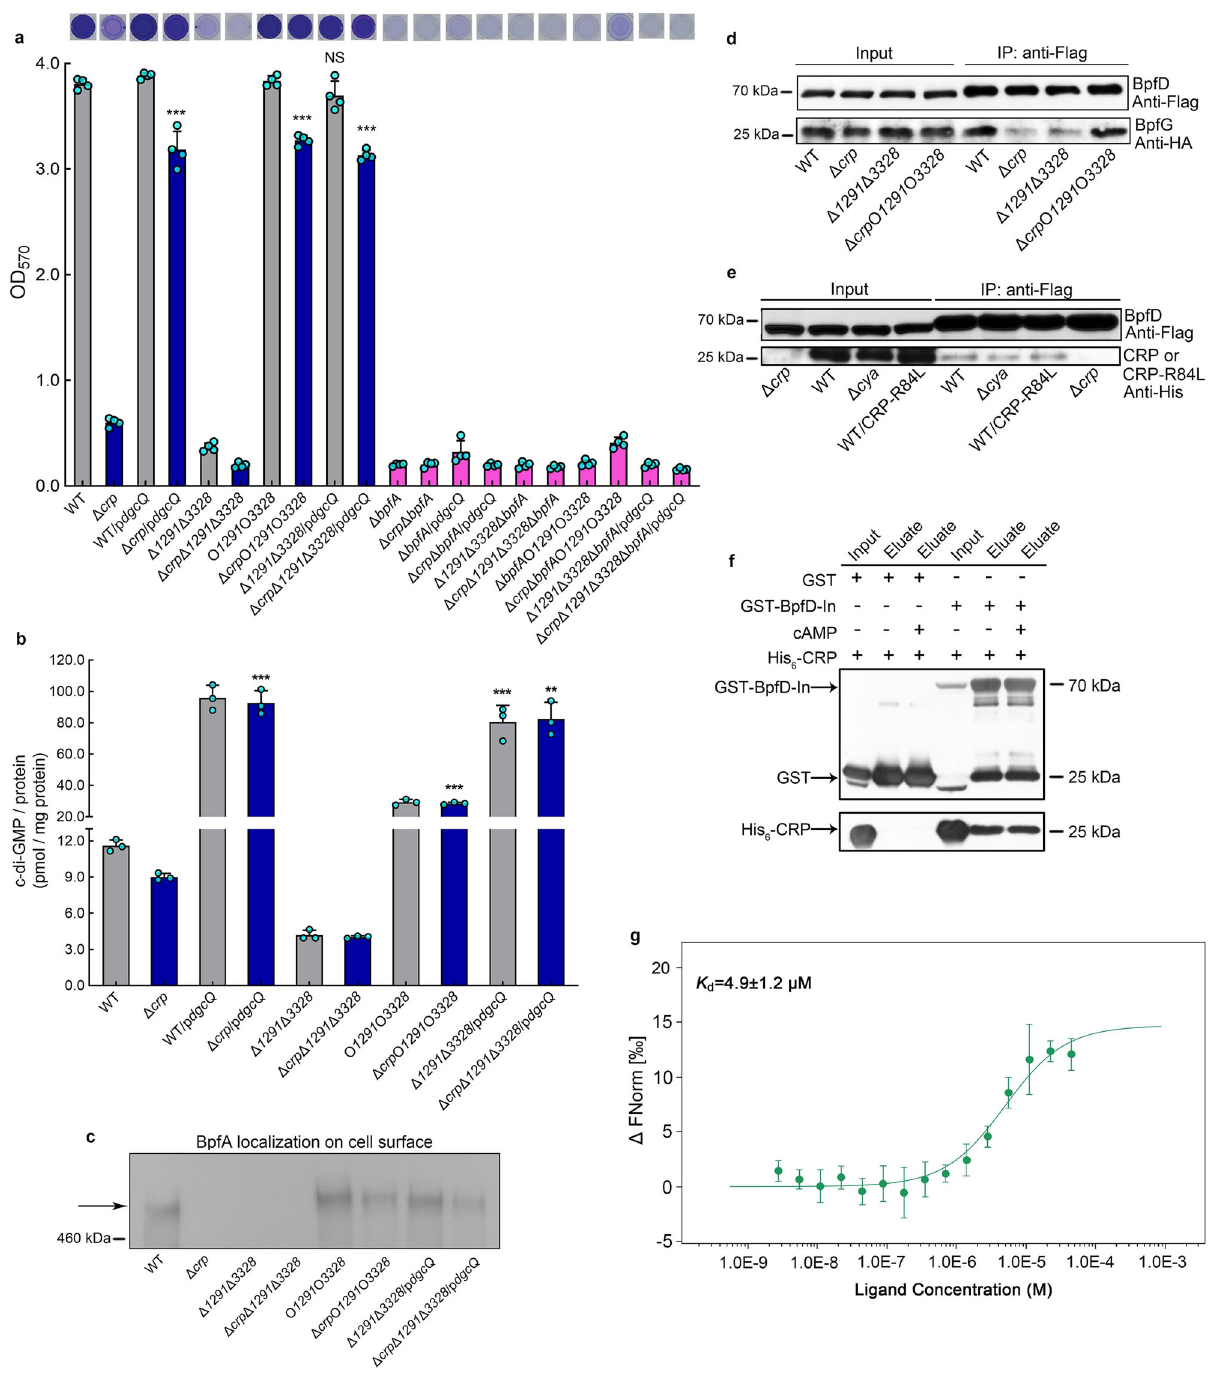
Fig. 5 Direct interaction between cAMP-CRP and BpfD retains BpfA localization on the cell surface. a Bio fi lm biomass ( n = 3 independent samples). b Intracellular c-di-GMP concentration ( n = 3 independent samples). c Western blotting detection of BpfA localization on the cell surface. d Co-IP to analyze the interaction between BpfD and BpfG in vivo. e Co-IP to analyze the interaction between BpfD and CRP/CRP-R84L in vivo. All strains used in ( a – e ) were cultured for 30 h in the bio fi lm state. f GST pull-down assay showing the interaction between BpfD intracellular domains and CRP in vitro. g MST showing the interaction between BpfD intracellular domains and CRP in vitro, data are shown as the mean ± SD ( n = 3 independent samples). The native promoter region of the bpfA operon of the strains used in ( c – e ) was replaced by the constitutive promoter P aacC1 . Insets in ( a ) are the bio fi lm pictures of crystal violet dyeing. Data in ( a , b ) are shown as the mean ± SD. Two-sided Student ’ s t test was used in ( a , b ) to analyze the statistical signi fi cance (NS: No signi fi cance. ** p < 0.01. *** p < 0.001). Source data are provided as a Source Data fi le.